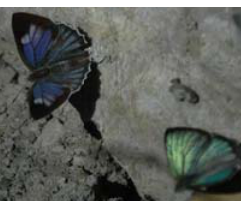
Image 41. Silver Hairstreak, Chrysozephyrus syla male